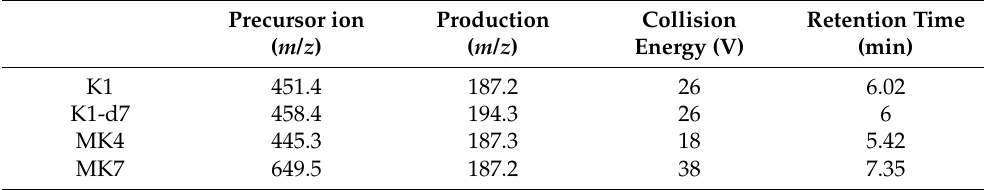
Table 1. LC-MS/MS